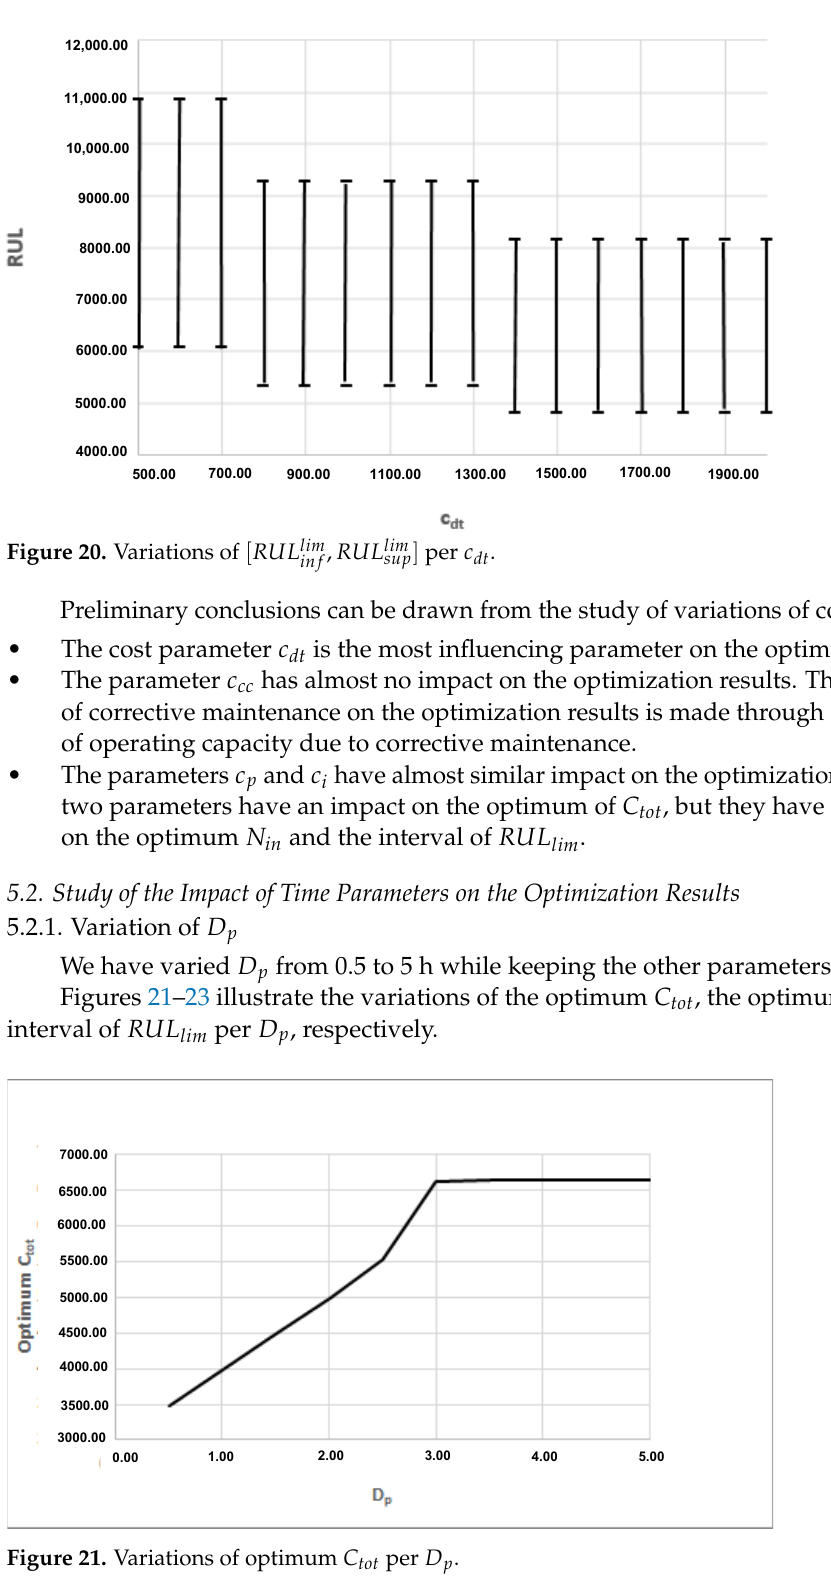
Figure 21. Variations of optimum C tot per D p